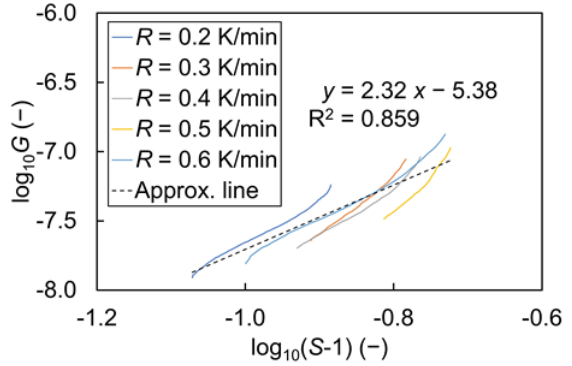
Figure 5. The regression analysis expressed in Equation (26) for the estimation of the kinetic parameters of the growth.